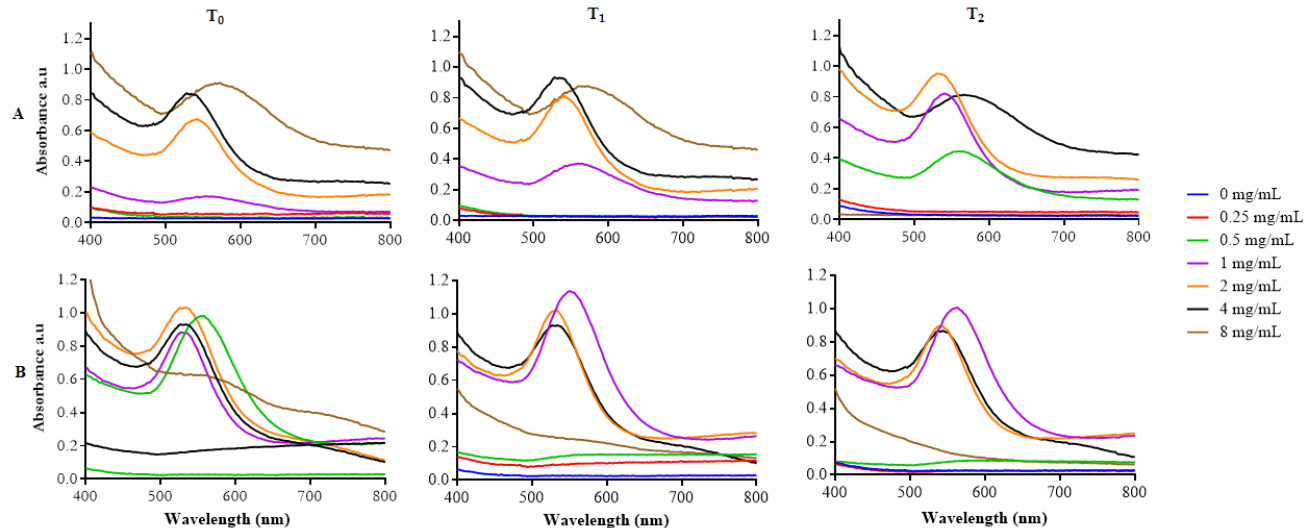
Figure 1. Synthesis of HB-AuNPs using different concentrations of HBE at 25 ◦ C ( A ) and 70 ◦ C ( B ). Optical properties of the HB-AuNPs were measured at 0–2 h, designated as T 0 –T 2